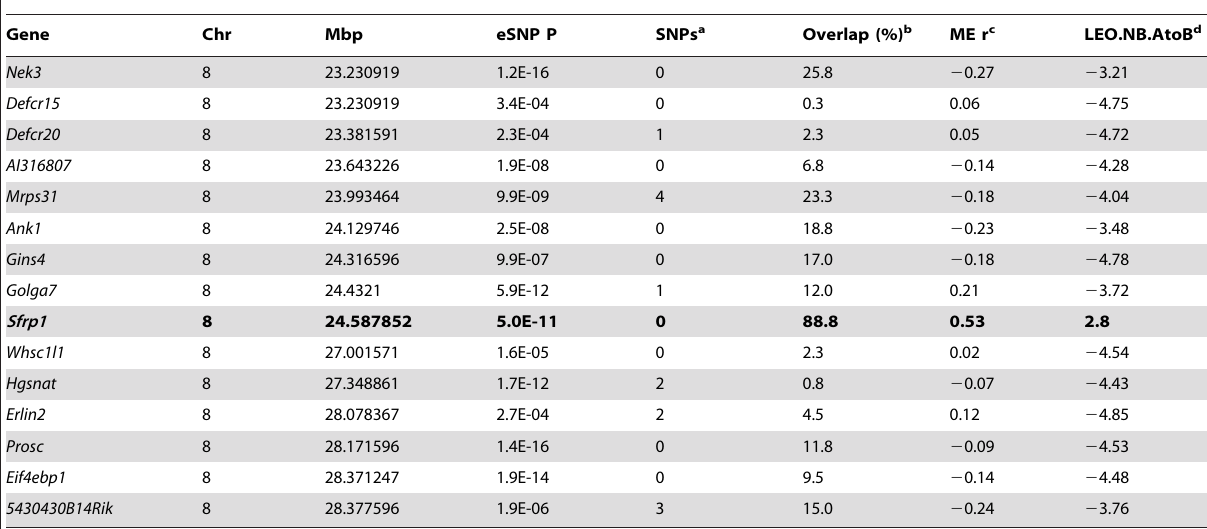
Table 3. Sfrp1 is predicted to be a regulator of the